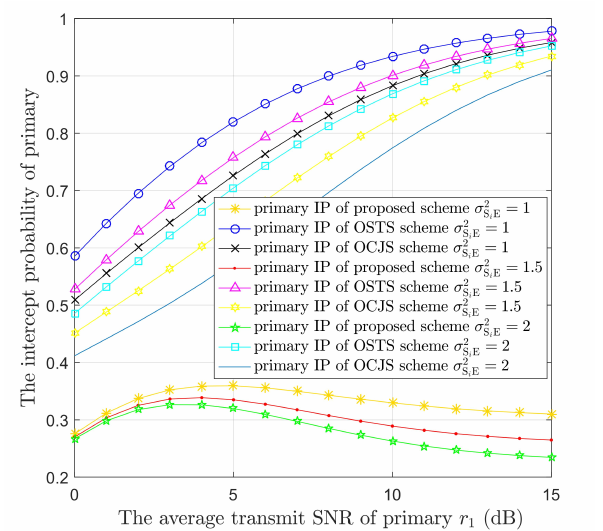
Figure 5. The IPs of the PUs versus the average transmit SNR of primary ( r 1 ) in the three protocols ) ) values. with different channel coefficient ( σ 2 S i E